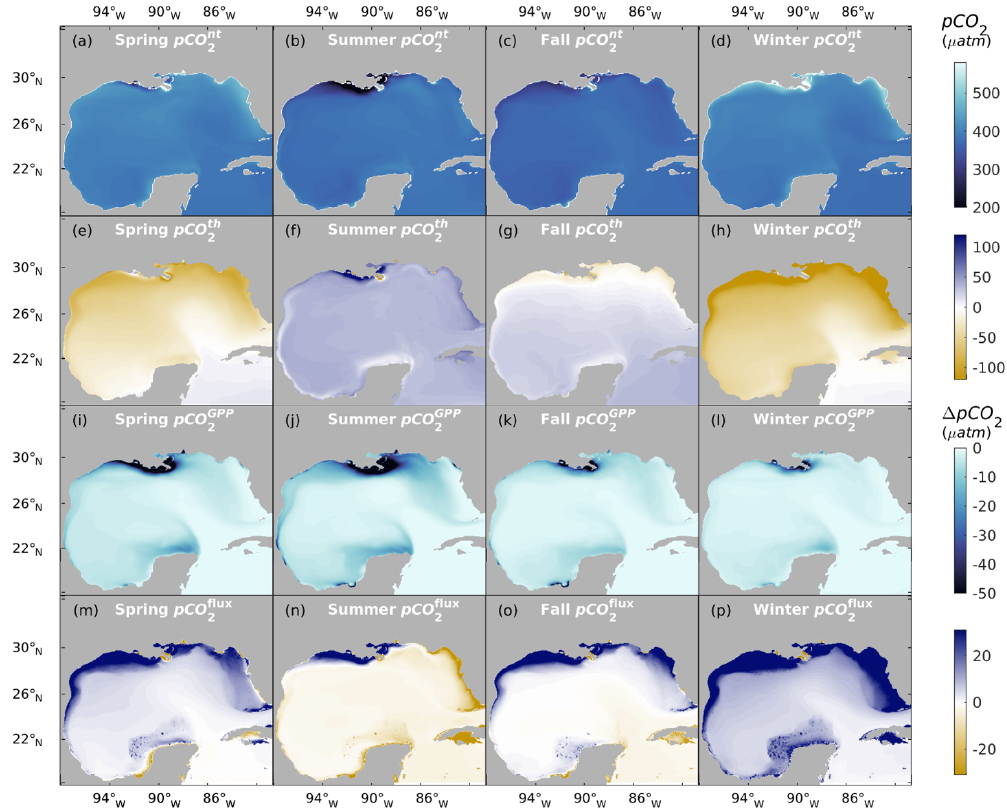
Figure 8. Spatial distribution of sea surface p CO 2 over four seasons. From the top to the bottom row: p CO th